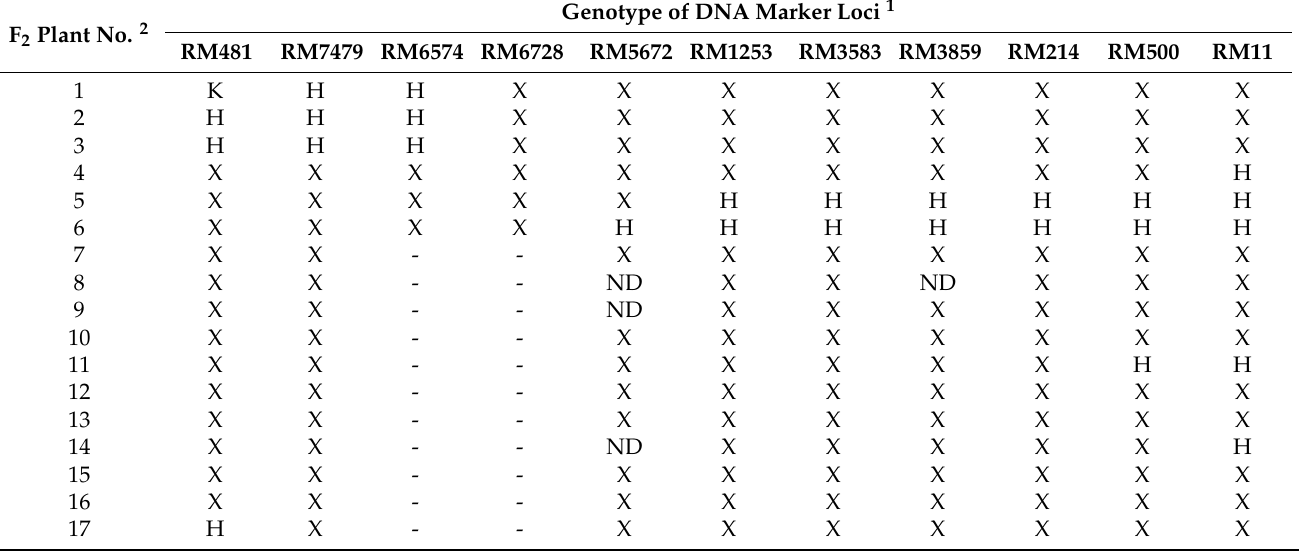
Table 4. Genotypes of DNA markers on chromosome 7 of 37 selected resistant plants against Japanese Xoo race III in the F 2 population from the cross between XM5 and Kinmaze. F 2 Plant No.